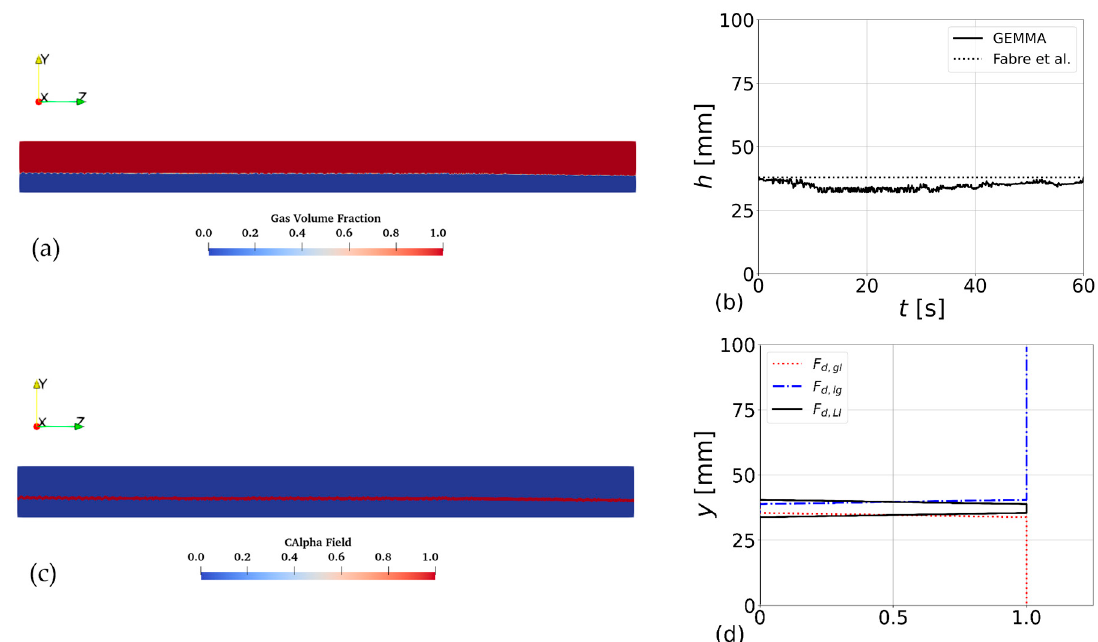
Figure 1. CFD results for phase distribution, liquid level and interface detection for the 250 experiment of Fabre et al. [30]. ( a ) Two-dimensional air distribution in the channel; ( b ) liquid height behaviour with time 9.1 m from the inlet, obtained from averaging the liquid void fraction across the channel height; ( c ) two-dimensional distribution of C α ; ( d ) contribution of the individual drag models to the overall drag force as a function of channel height.